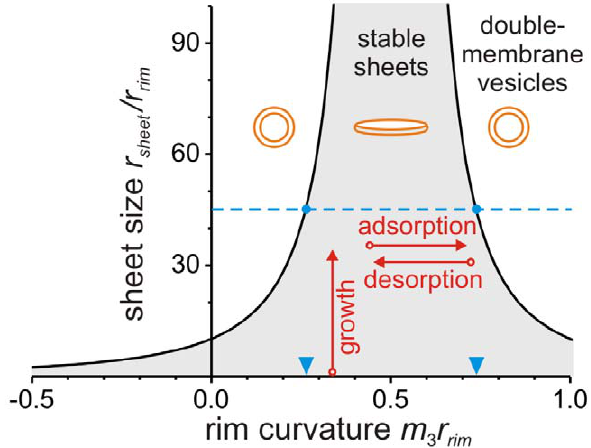
Figure 4. Stability diagram of double-membrane sheets as a function of preferred or spontaneous rim curvature m 3 and sheet size r sheet . Both the rim curvature and sheet size are given in units of the rim curvature radius r rim . The sheets are (almost) symmetric in the sense that their two faces have similar preferred curvatures, m 1 > m 2 and the curvature asymmetry m 12 is small compared to 1/ r rim . The regime of stable sheets (gray area) is bounded by an instability line corresponding to the critical sheet size as described by Equation 10 in Text S1. The instability line has two branches for m 3 r rim , 1/2 and m 3 r rim . 1/2. For nonzero m 12 the two branches meet at the maximal critical disk size as given by 2/ |m 12 | . The latter size diverges for vanishing curvature asymmetry m 12 =0, i.e., in this case, an arbitrarily large sheet remains stable. If the sheet reaches the instability line by lateral growth, protein adsorption and/or desorption at its rim (long arrows), it closes into a double-membrane vesicle. Sheets above the instability line are unstable and close into such vesicles as well. The broken horizontal line with r sheet / r rim > 45 corresponds to the autophagosome in Fig. 2C with diameter r 0 sheet > 900 nm and r rim > 20 nm. The intersection of the broken line with the two branches of the instability line determines the preferred or spontaneous rim curvature m 3 > 1/(76 nm) or 1/(28 nm) (arrowheads) of the unstable sheet that preceded the autophagosome in Fig. 2C.